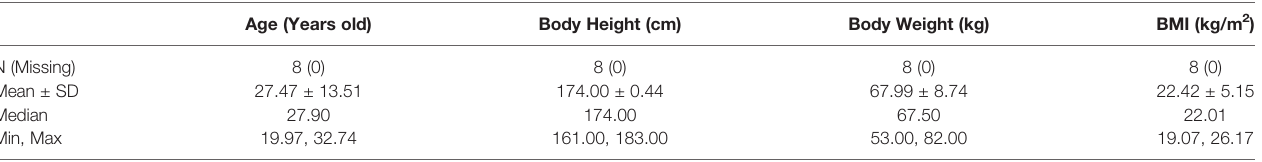
TABLE 1 | Demographic characteristics of the subjects.